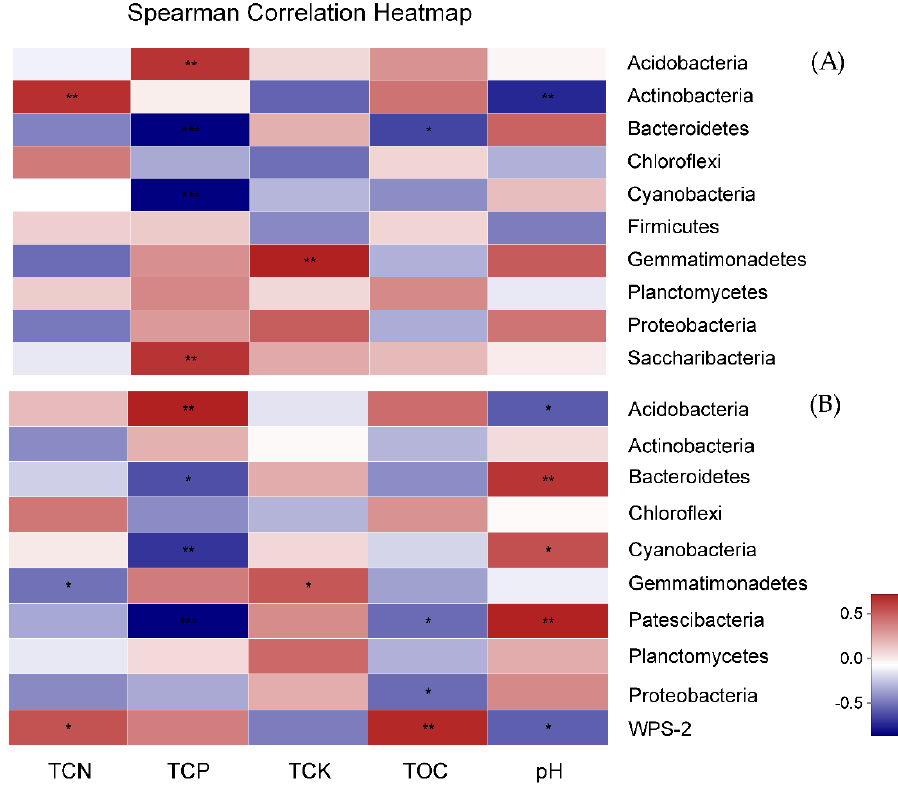
Figure 5. The heatmap of the correlation between bacterial phyla and physicochemical characteristics of rhizospheric soil in winter ( A ) and summer ( B ). NCS, fallow field soil; CyS1, one-year C. chinensis cultivated soil; CyS3, three-year C. chinensis cultivated soil; CyS5, five-year C. chinensis cultivated soil. TCN, total content of nitrogen; TCP, total content of phosphorus; TCK, total content of potassium; TOC, total organic carbon; and pH. The heatmap was created according to the results from the Spearman’s correlation analysis. Positive correlations are represented in red, while negative correlations are represented in blue. The significant correlations are presented as asterisks (*, P < 0.05; **, P < 0.01, ***; P < 0.001).